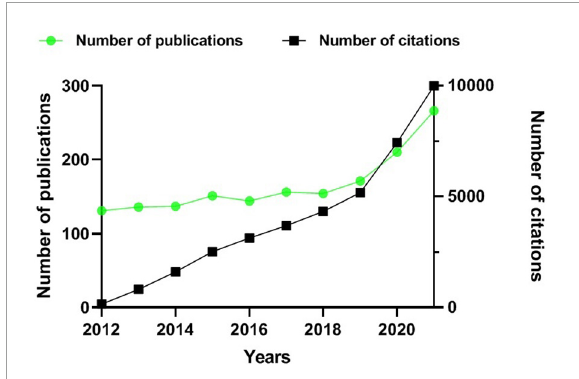
FIGURE2 Publications and citations over time (2012–2021). The green line indicates the number of publications. The black curve indicates the number of cited